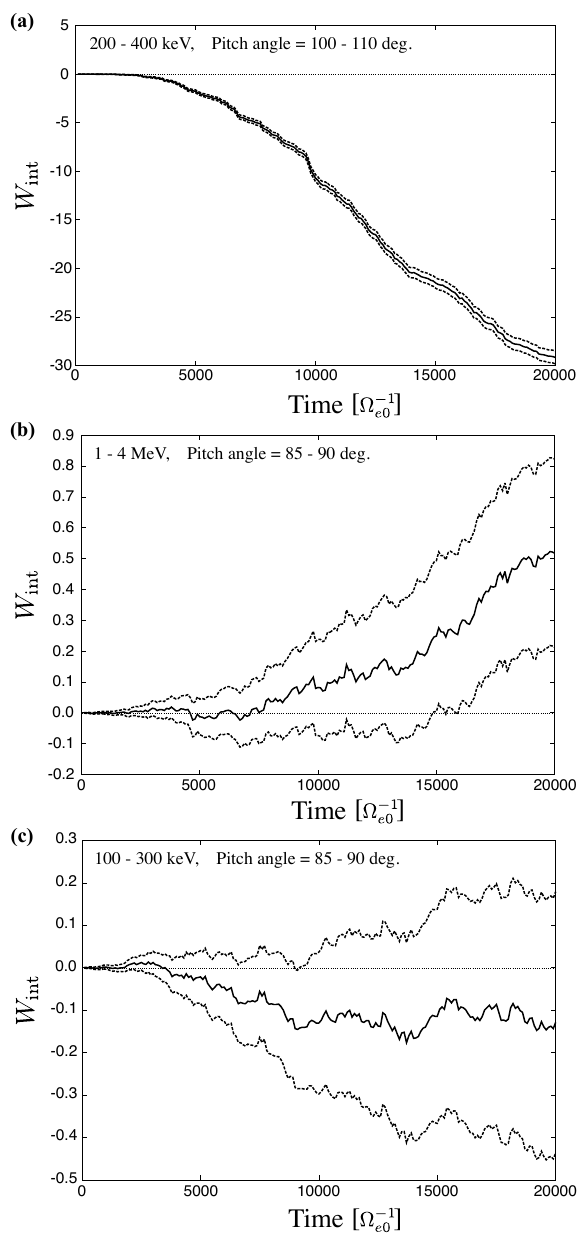
Fig. 4. Time histories of W int in (a) Region A, (b) Region B, and (c) Region C of velocity space. Energetic electrons passing through the observation point toward the magnetic equator are used in the computation. Dashed lines denote W int ± 1 . 96 σ W .